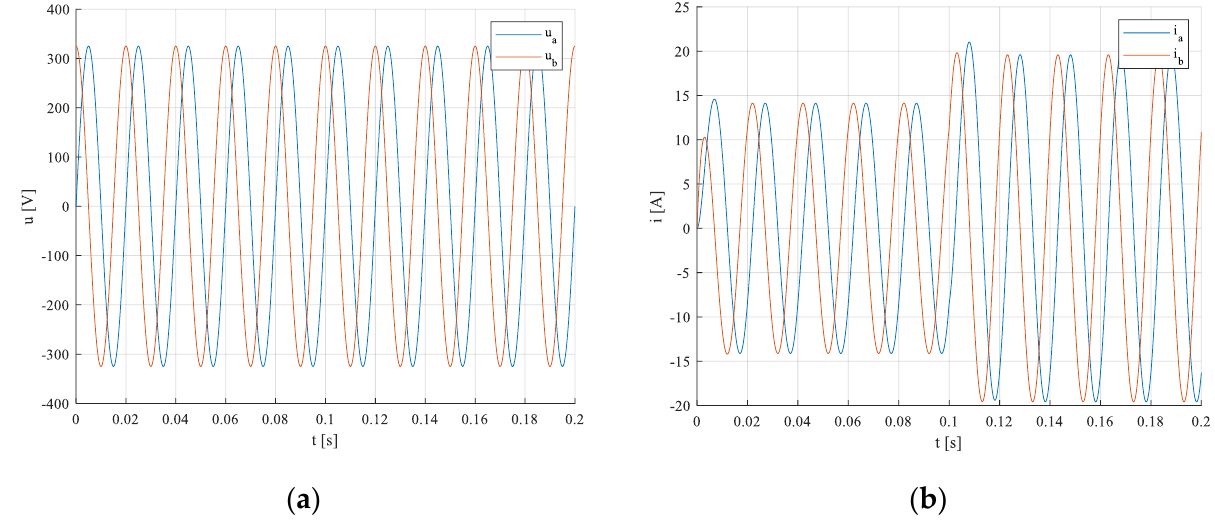
Figure 10. Phase voltages ( a ) and load currents ( b ) in α , β coordinates. RL